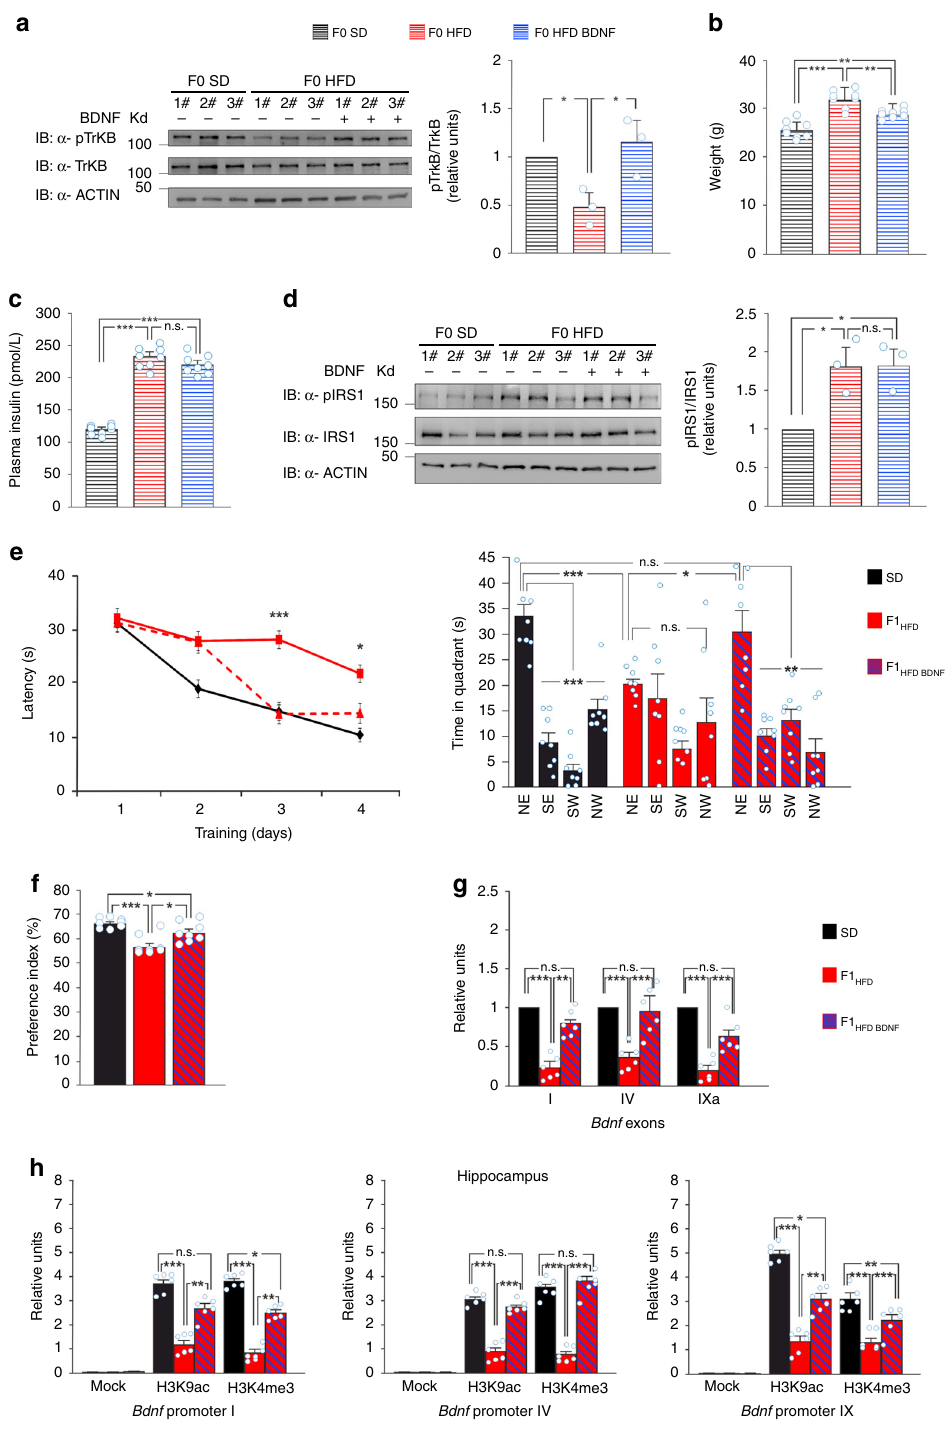
F 4.1 = 70.99 for H3K4me3, p = 6.2 × 10 − 5 ; n = 6; two-way hippocampus of F1 HFD BDNF mice ( F 4.1 = 40.07 for exon I, F1 HFD = 0.0018; F = 17.97 for exon IV, F1 ANOVA; Fig. 7h). Collectively, our fi ndings reveal a critical 4.1 HFD BDNF BDNF vs. F1 HFD p vs. F1 HFD p = 0.00039; F 4.1 = 49.23 for exon IXa, F1 HFD BDNF vs. role of BDNF signaling in the mother to offspring transmission of F1 HFD p = 0.00067; n = 6; two-way ANOVA; Fig. 7g). Accord- HFD-dependent cognitive de fi cits. ingly, epigenetic marker activation on the regulatory sequences of Bdnf gene were higher in the hippocampus of F1 HFD BDNF mice compared to that in F1 HFD (promoter I: F 4.1 = 14 for H3K9ac, p66Shc de fi ciency abolishes HFD intergenerational effects . To p = 0.0051, F 4.1 = 28.75 for H3K4me3, p = 0.0013; promoter IV: investigate the causative role of maternal insulin resistance in the F 4.1 = 74.19 for H3K9ac, p = 0.00011, F 4.1 = 43.49 for H3K4me3, intergenerational transmission of HFD-related changes of brain p = 0.00045; promoter IX: F 4.1 = 13.71 for H3K9ac, p = 0.0074, function, we used p66Shc knockout (KO) mice. p66Shc is one of NATURE COMMUNICATIONS| (2019) 10:4799